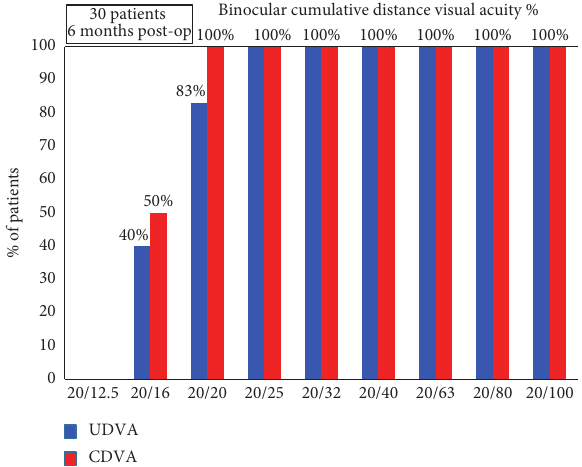
Figure 1: Cumulative histogram for binocular UDVA and CDVA at 6 months